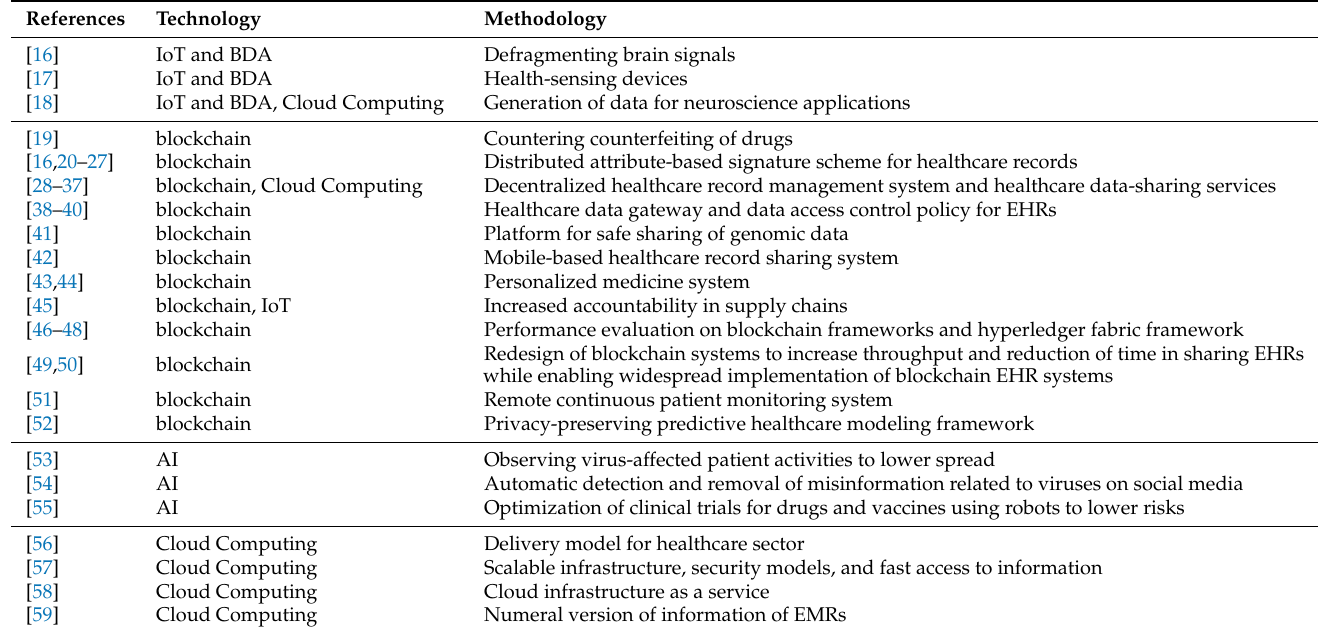
Table 1. Existing literature on Industry 4.0 and Healthcare